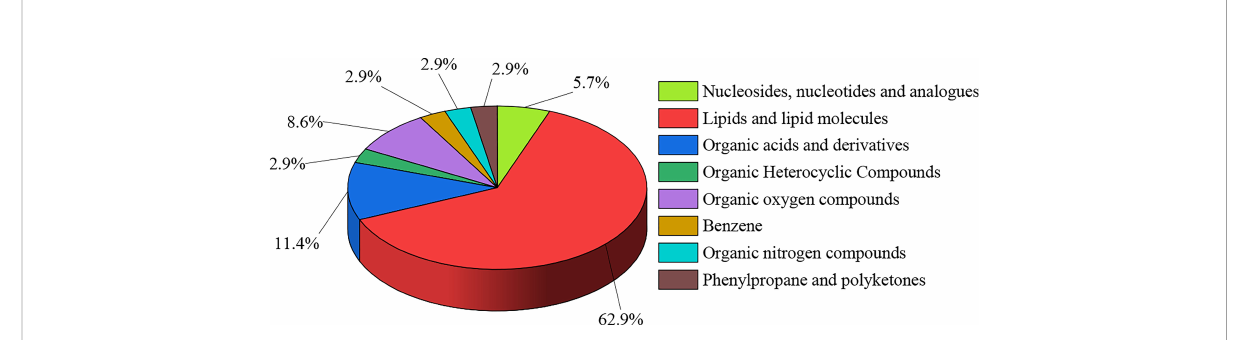
FIGURE 1 Classi fi cation map of differential compounds in maize root exudates after AMF